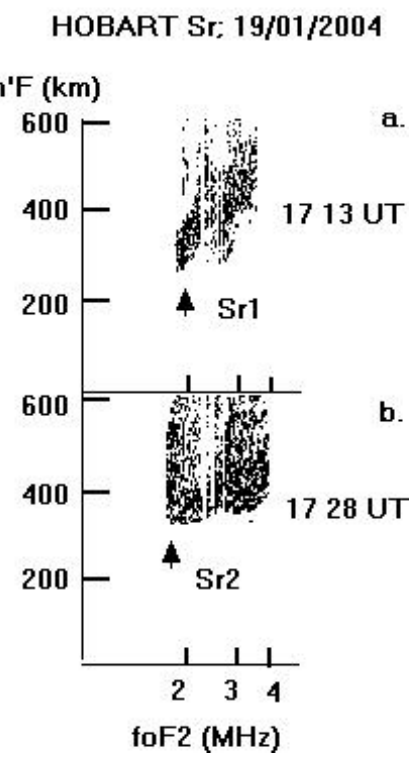
Fig. 2. Typical example of range spread-F intensified to a maximum at 17:28 UT (03:28 LT) at a low end of the ionosonde sounding fre- quency (1.8MHz) at a sub-auroral station Hobart; here Sr1=100km and